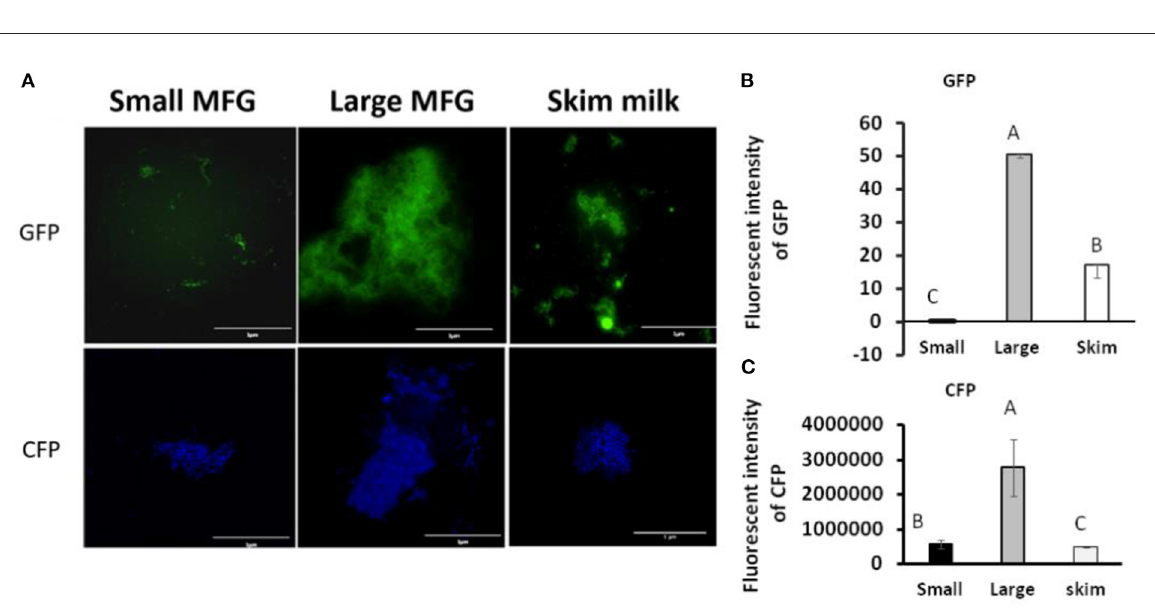
FIGURE4 MFG size affects biofilm formation by B. subtilis . (A) representative image of B. subtilis tagged with GFP (upper row, green) and CFP (bottom row, blue) reporter incubated with either small or large MFG compared to incubation in skim milk as a control. (B) Integrated fluorescence intensity of GFP and (C) CFP. The fluorescence density was measured using ImageJ. Values represent means of 2 independent experiments, with 3 replicates for each treatment ( n = 3). Different letters represent significant differences between treatments ( P ≤